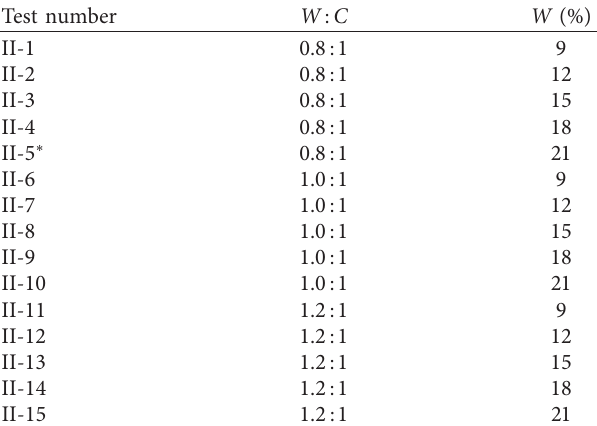
Table 6: Comprehensive test